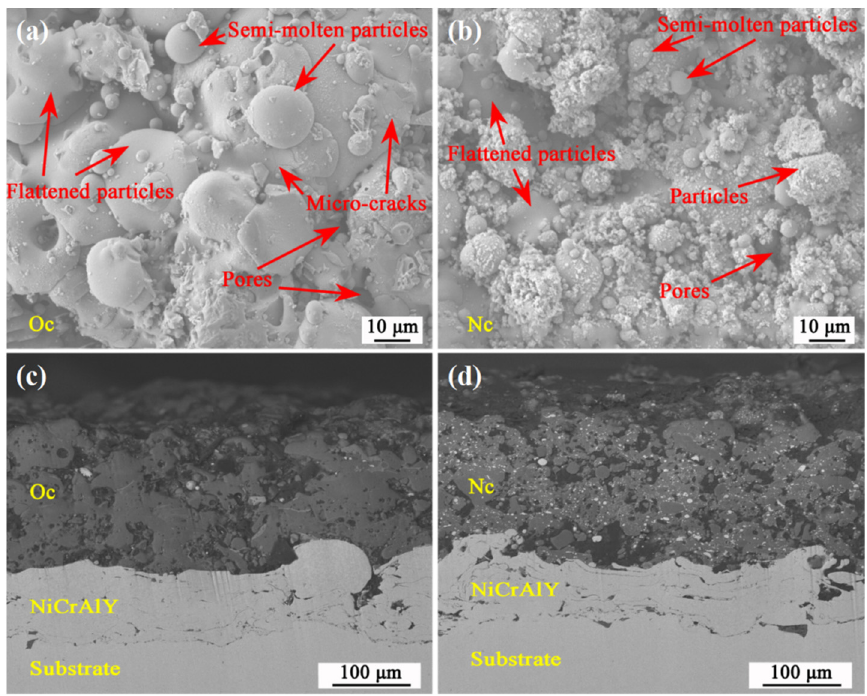
Figure 7. SEM images of the top surfaces of the as-sprayed coatings: ( a ) O C , ( b ) N C , and ( c,d ) their polished cross sections (mode: BSE), respectively.